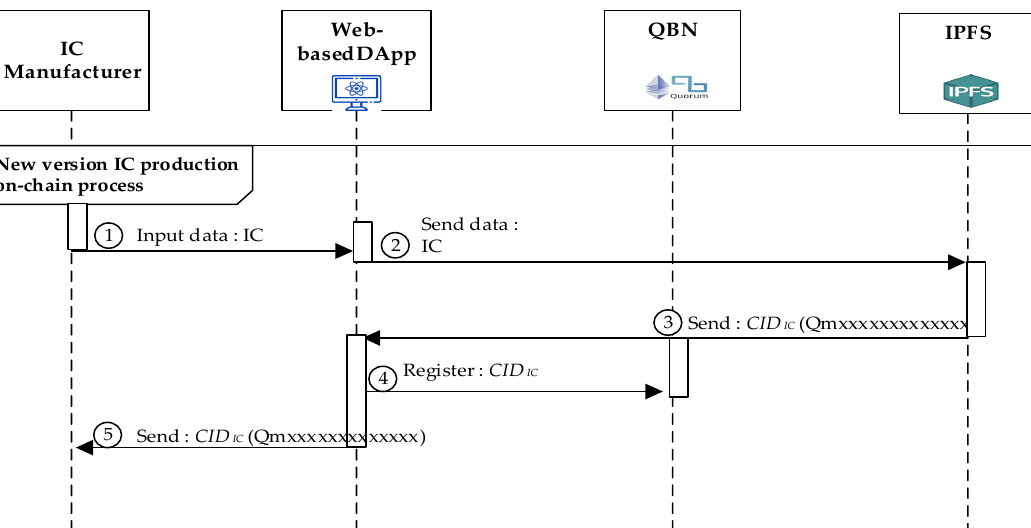
Figure 7. The sequence diagram of producing the new version of IC. New IC Chip Producing Procedure